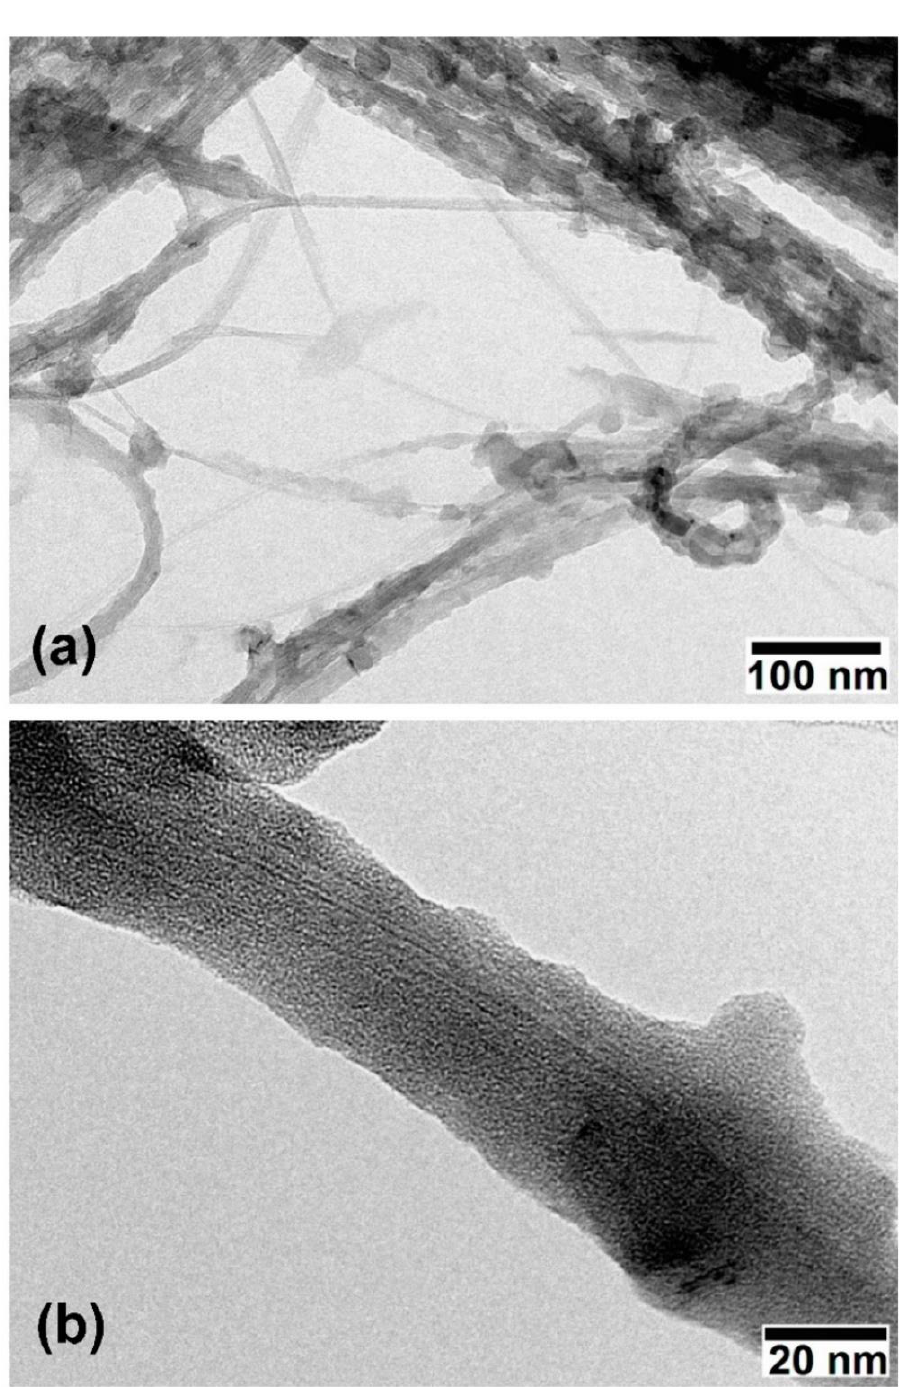
Figure 3. TEM images of CNTs–PAMAM–Ag. ( a ) revealed the efficient entanglement of CNTs by success-fully conjugating PAMAM chains onto their surfaces. ( b ) The PAMAM grafted to the surface of CNT and the deposition of spherical-shaped Ag